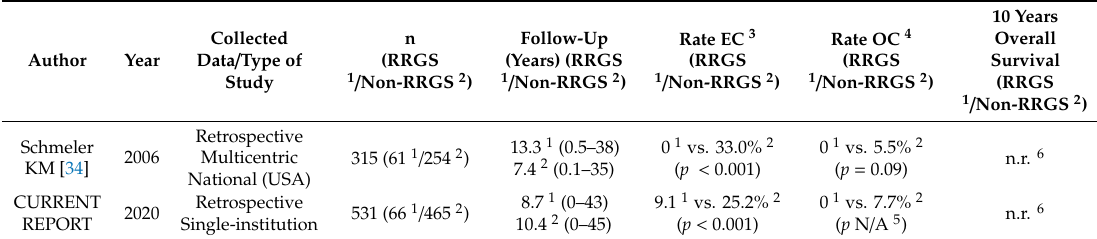
Table 7. Studies comparing gynecological cancer incidence and survival between risk reducing gynecological surgery and surveillance in Lynch syndrome